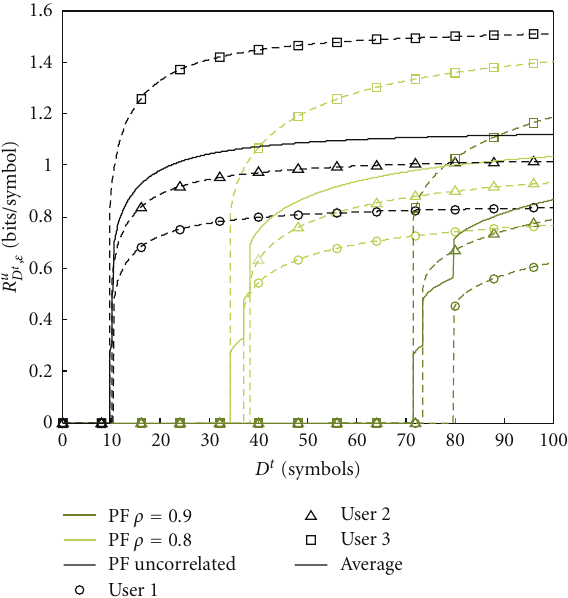
Figure 8: Achievable users’ rates with Proportional Fair scheduling in a time-correlated channel with exponential ACF of parameter ρ .